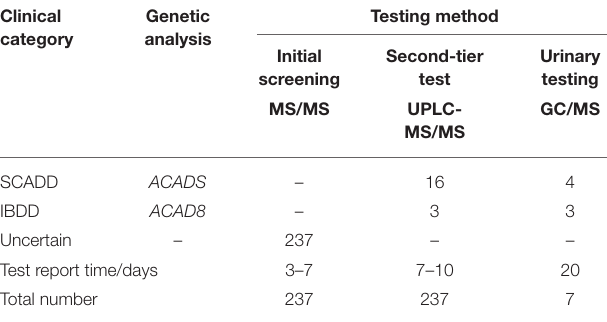
TABLE 5 | Results of second-tier test compared to initial screening by MS/MS and urinary GC/MS (2019.03–2020.03). Clinical